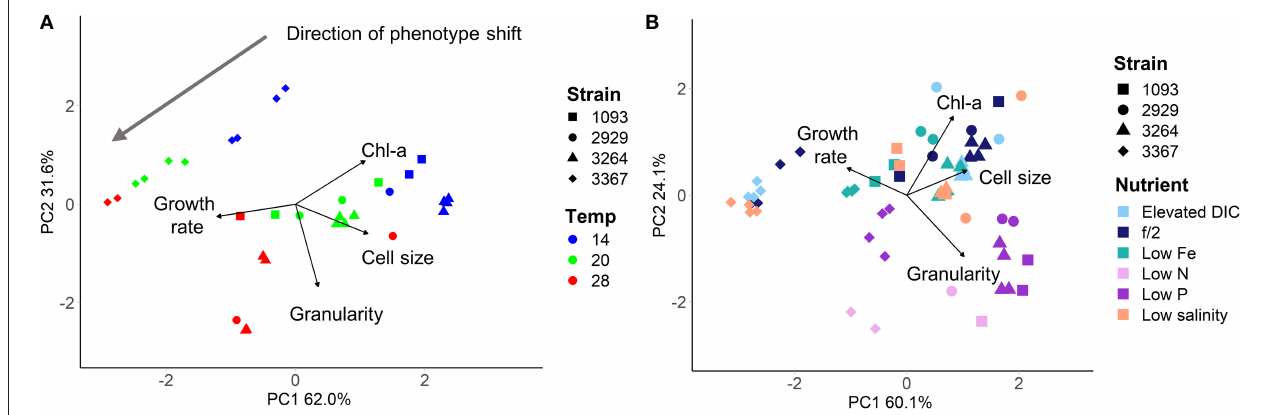
FIGURE 4 | Four Thalassiosira strains grown under differing culture conditions, visualised using Principal Component Analysis. (A) Strains grown in f/2 media under 200 µ mol m − 2 s − 1 light in three different temperatures (colours - showing unidirectional shift in the trait scape). (B) Strains grown at 20 ◦ C with 200 µ mol m − 2 s − 1 light in six different nutrient environments (colours). Directional shifts in phenotype can be seen in the low nitrogen and low phosphorus treatments.